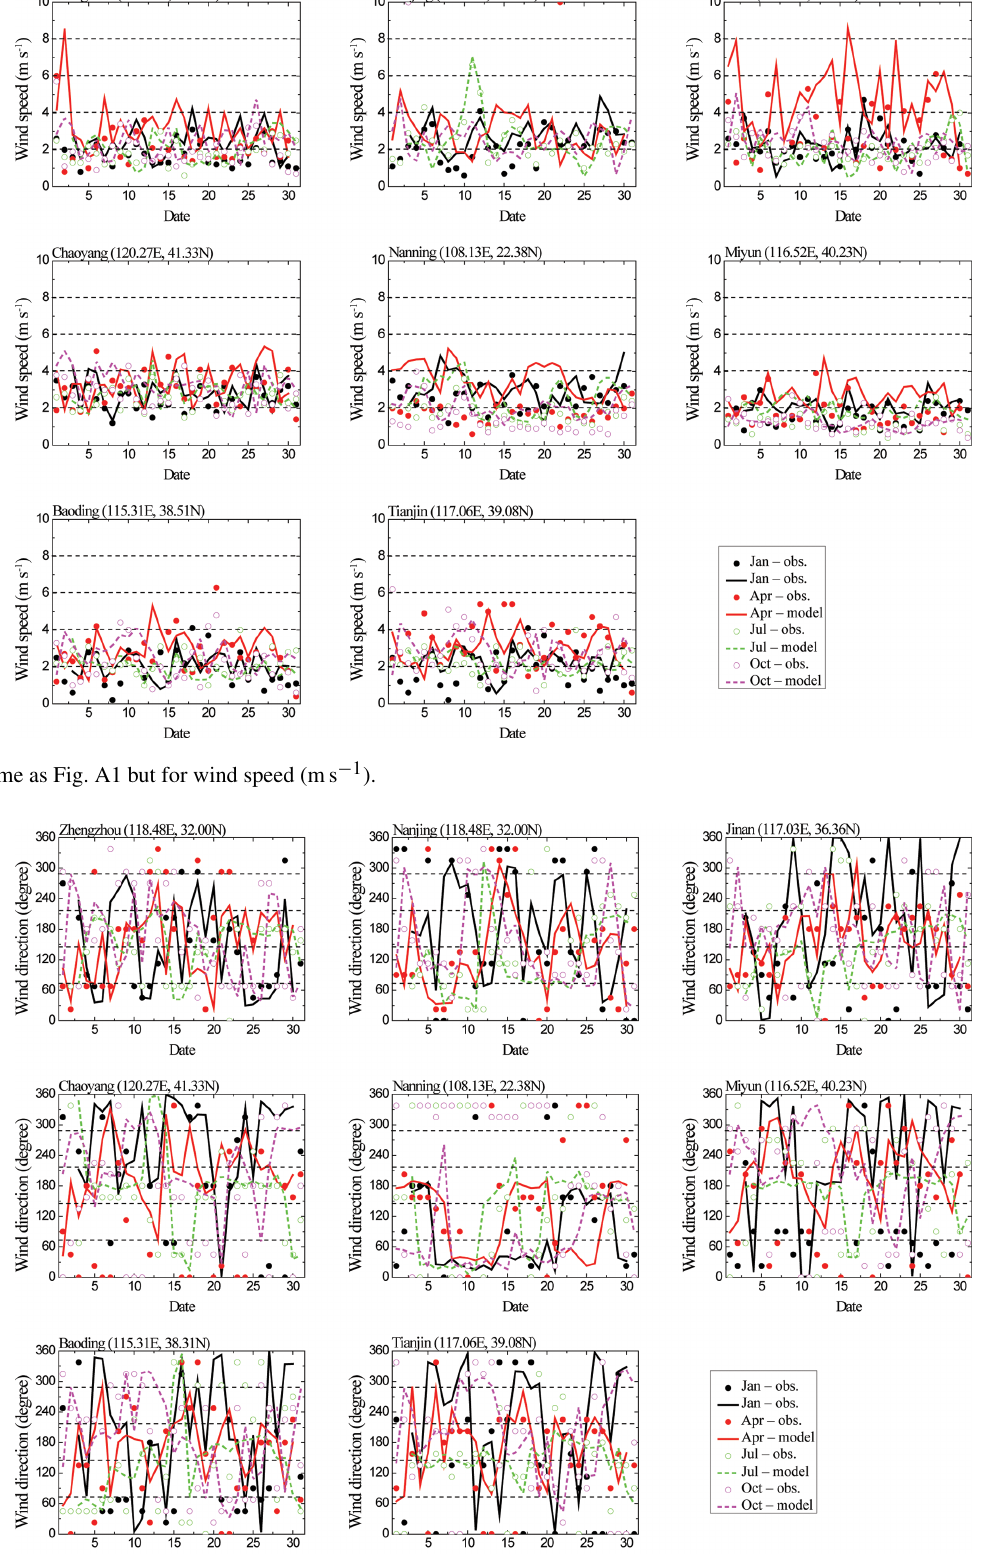
Figure A4. Same as Fig. A1 but for daily maximum wind direction ( ◦